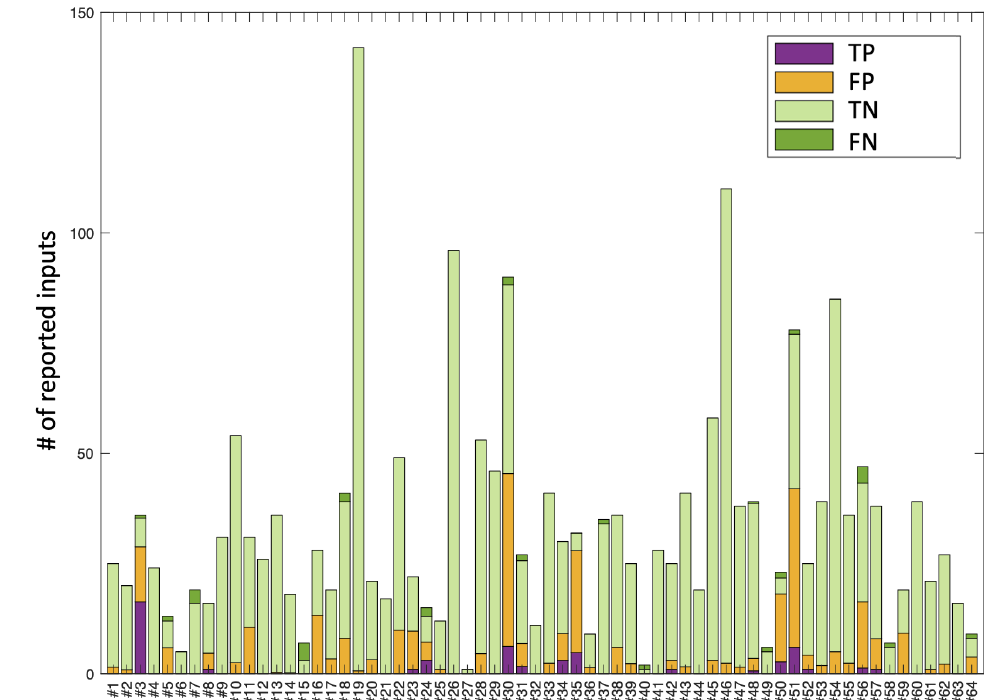
Figure 4. Representation of the results of the Leave-One-Subject-Out Cross-Validation test in terms of the vectorised confusion matrices scaled by the proportion of entries each subject made in the application. The vertical axis represents the number of entries for each user. We use the colour convention from Figure 3 to represent the TP (True Positives), the FP (False Positives), the TN (True Negatives) and the FN (False